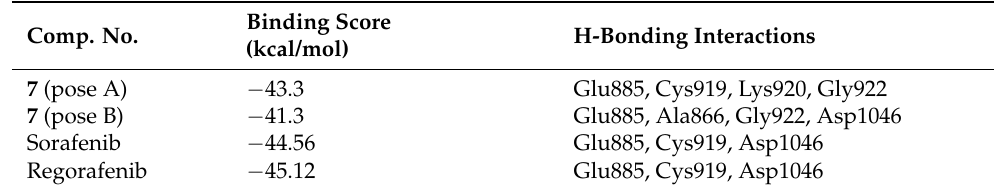
Table 5. Binding score and the H-bonding interactions of target compound 7 , sorafenib and rego- rafenib in the active ATP binding site of VEGFR2 kinase. Comp. No.